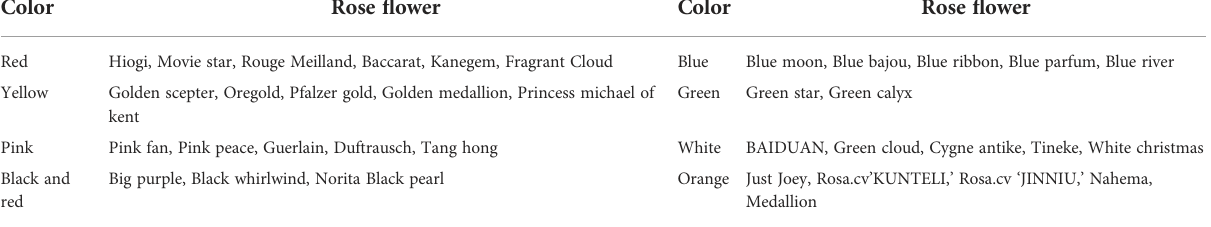
TABLE 2 Corresponding table of Chinese roses ’ color and species.